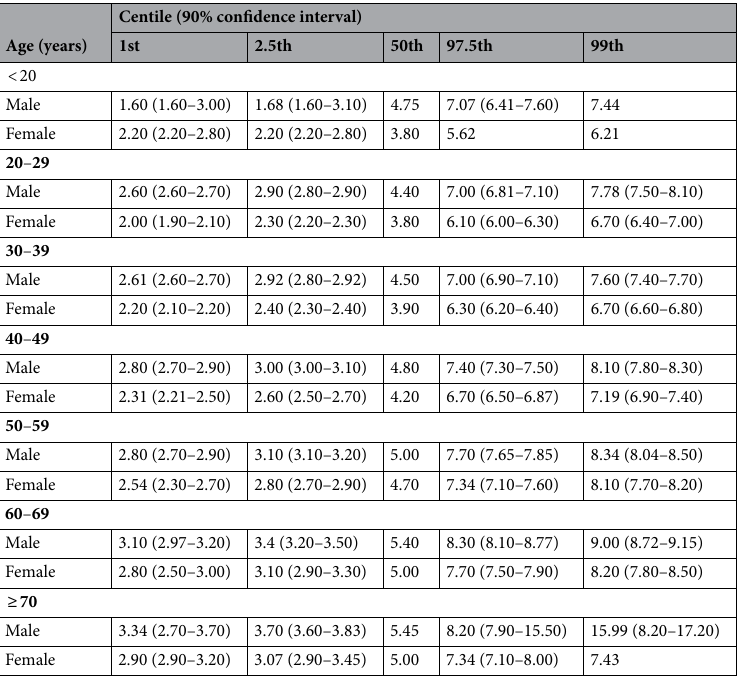
Table 4. Blood urea nitrogen values (mmol/L) centiles of the age groups in males and females population. The 50th centile is shown as a point estimate only, as a reference